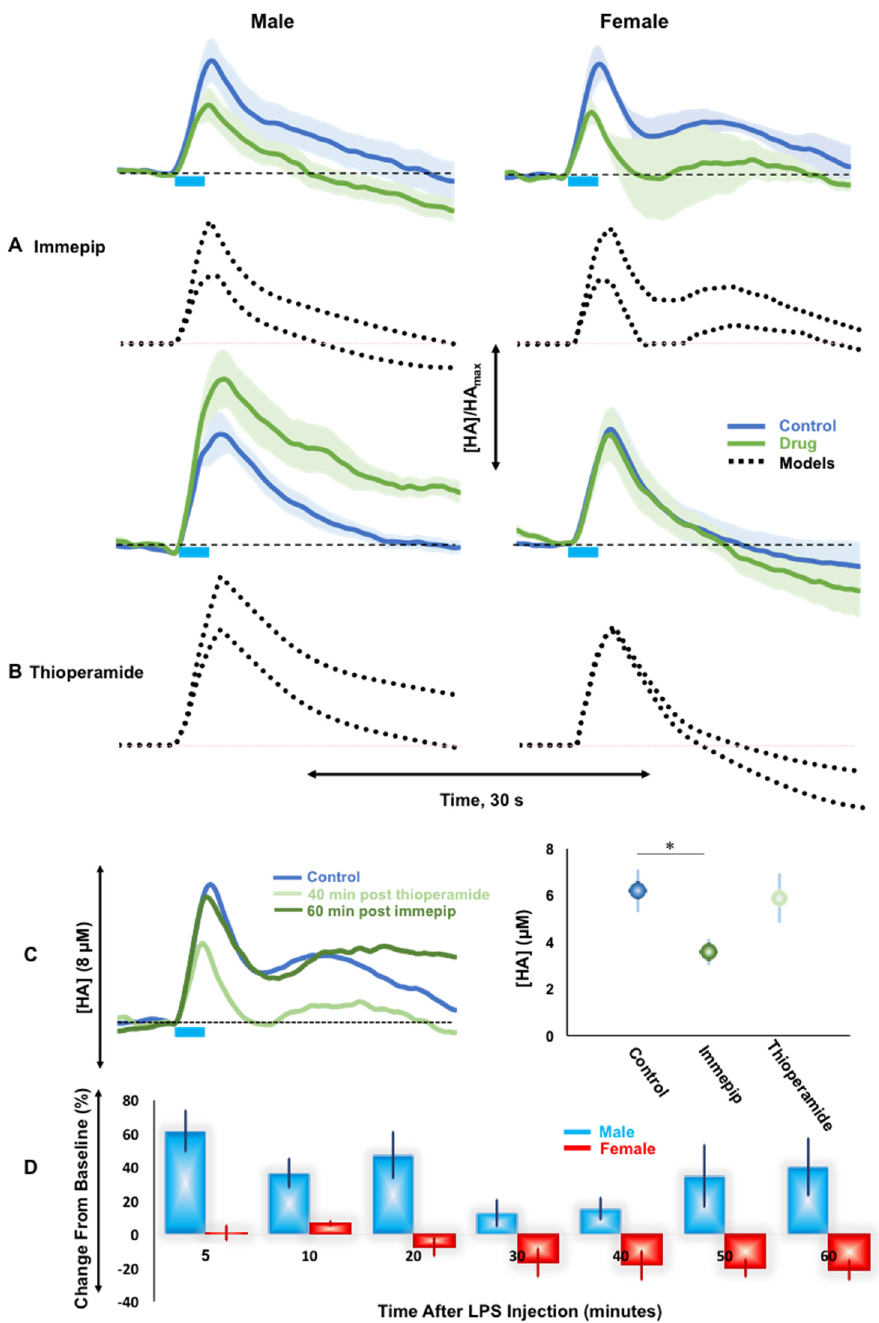
Figure 3. ( A , B ) The drug and mouse’s sex are listed. Concentration vs. time traces for control (blue) and post-drug (green) evoked histamine. The mathematical model results are in black dotted lines. ( C ) [HA] vs. time profiles of evoked histamine for control ( n = 5, blue), 60 min following immepip ( n = 5, dark green), and 40 min following thioperamide after 60 min immepip (n=4, light green). Max amplitude of evoked histamine for control (blue), 60 min immepip (dark green), and 40 min following thioperamide after initial 60 min immepip (light green). Significance between two points was taken as p < 0.05 ( D ) Male vs. female % difference (vs. control) in evoked histamine release with time after LPS injection. * = p < 0.05.